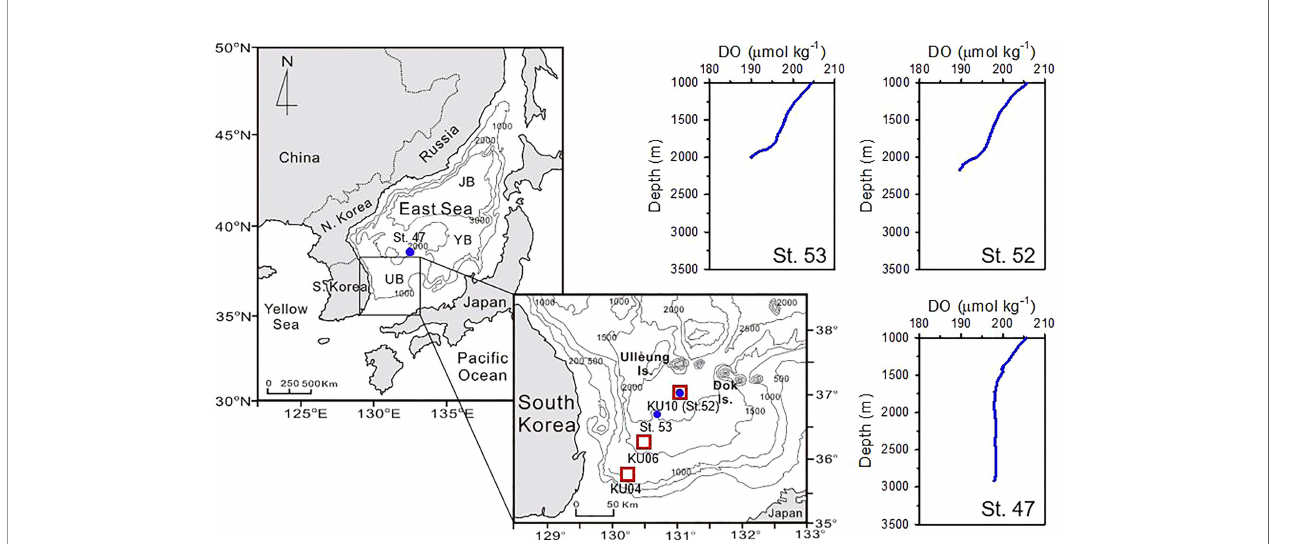
FIGURE 1 | Maps of sampling sites in the upper continental slope (KU04; 35° 49 ’ 48 ” N; 130° 9 ’ 36 ” E), lower slope (KU06; 36° 14 ’ 24 ” N; 130° 27 ’ 36 ” E) and rise (KU10; 37° 01 ’ 12 ” N; 131° 03 ’ 00 ” E) of the Ulleung Basin (UB). Vertical pro fi les of dissolved oxygen (DO) concentrations (St. 47, St. 52 and St. 53) were re-drawn from Kang et al. (2010). Unlike DO that measured outside the UB (St. 47), DO concentrations in the UB region (St. 52 and 53) show a sharp decrease in the bottom water